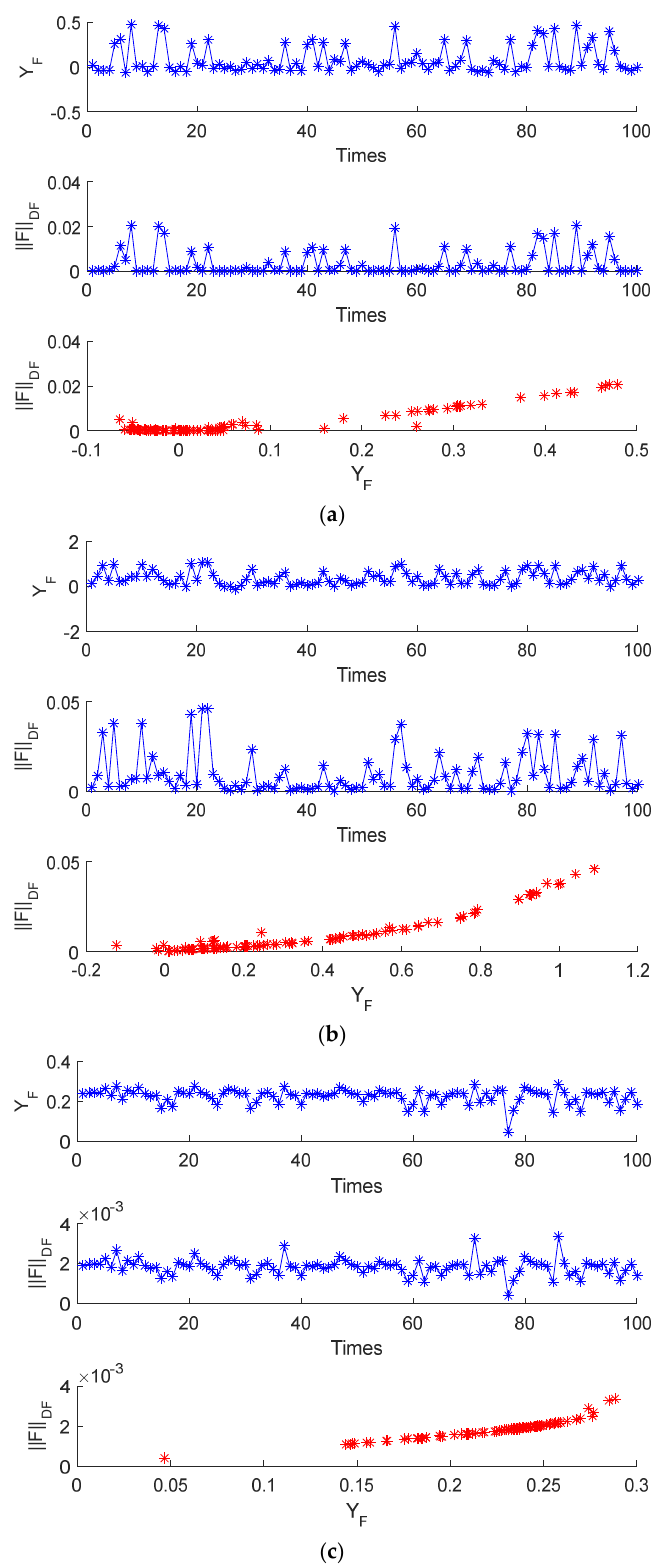
Figure 6. Distribution results of Y F and (cid:107) F (cid:107) ( b ) and ( c ),